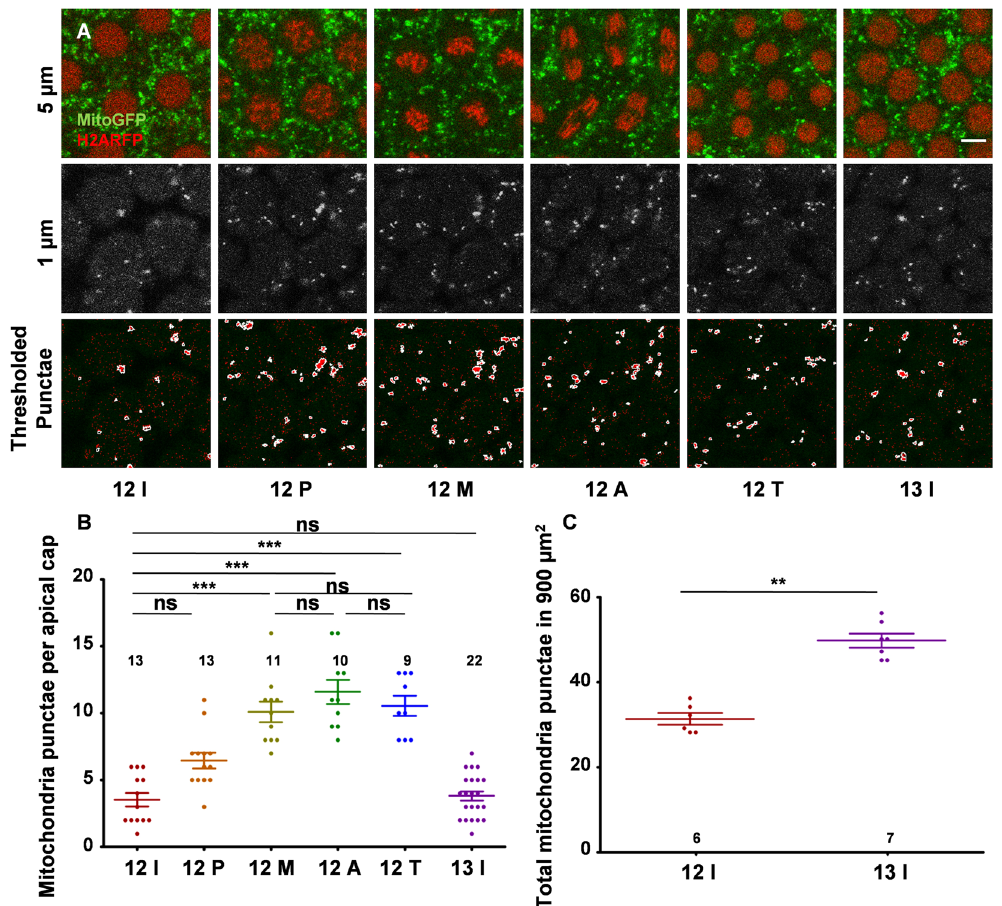
Figure 3. Apical mitochondrial punctae numbers remain constant across the syncytial division cycle. ( A ) Apical mitochondria increase during metaphase of the syncytial cycle. Live imaging of embryos expressing Mito-GFP (green) and Histone2A-RFP (red) is shown across the NC12 at 1 µ m and 5 µ m depths (12I: interphase NC12, 12 P: prophase, 12 M: metaphase 12 A: anaphase 12 T: telophase 13I: interphase NC13). At 1 µ m depth, mitochondria are present as discrete countable structures (2nd panel). Using ImageJ, distinct punctae are thresholded, marked and quantified (3rd panel). Scale bar A: 5 µ m. ( B , C ) Quantification of mitochondria across syncytial cycles. Number of distinctly separable mitochondrial puncta per syncytial cell significantly increases in metaphase and the number is conserved between 12I and 13I ( B ) (N = 4 embryos, 13, 13, 11, 10, 9, 22 syncytial cells for 12I, 12 P, 12 M, 12 A, 12 T and 13I respectively. ns–not significant; *** P ≤ 0.001, one way Kruskal Wallis test). Total number of mitochondria in 900 μ m 2 area are compared between 12I and 13I ( C ) (n = 6 and 7 embryos; each point is an average from 20 and 50 syncytial cells for 12I and 13 I respectively, ** P ≤ 0.01, two tailed Mann-Whitney